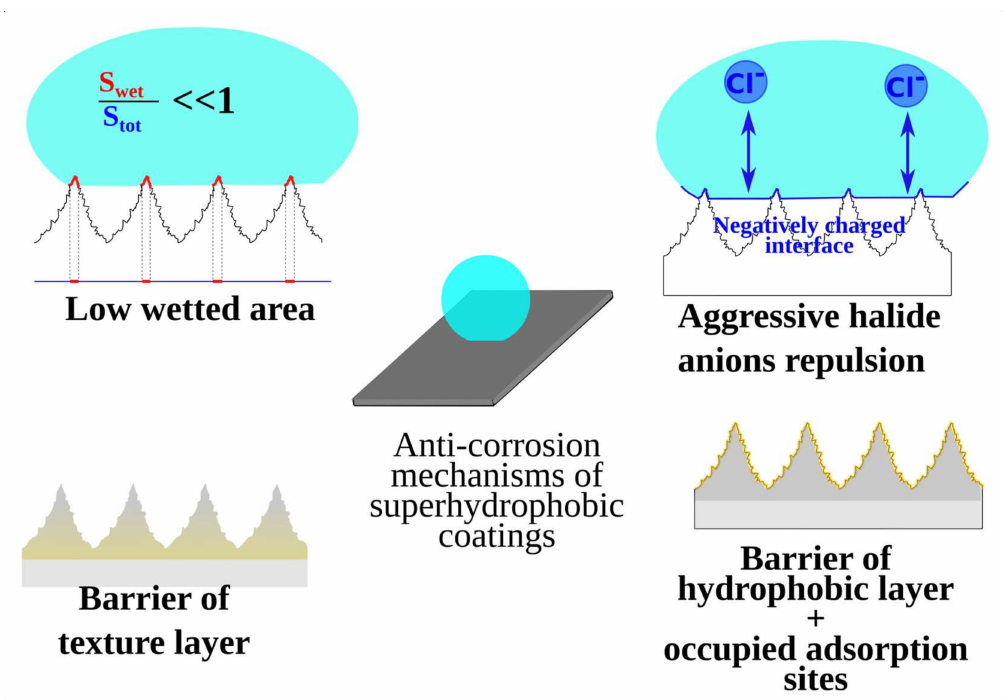
Figure 1. Mechanisms of corrosion protection of superhydrophobic coatings in electrolyte